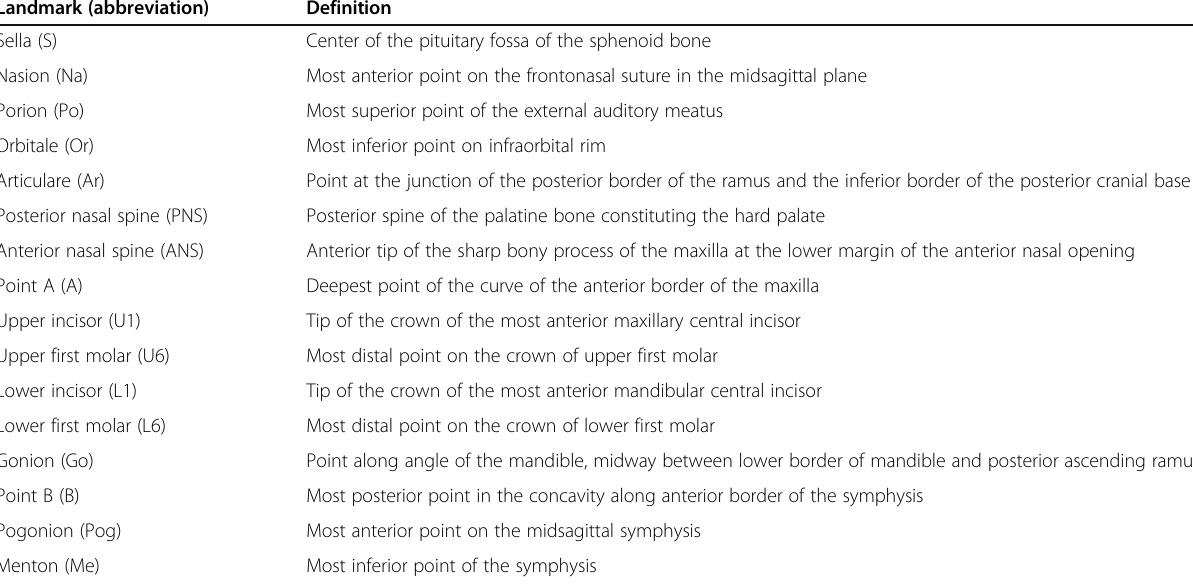
Table 1 Description of cephalometric landmarks used in this study Landmark